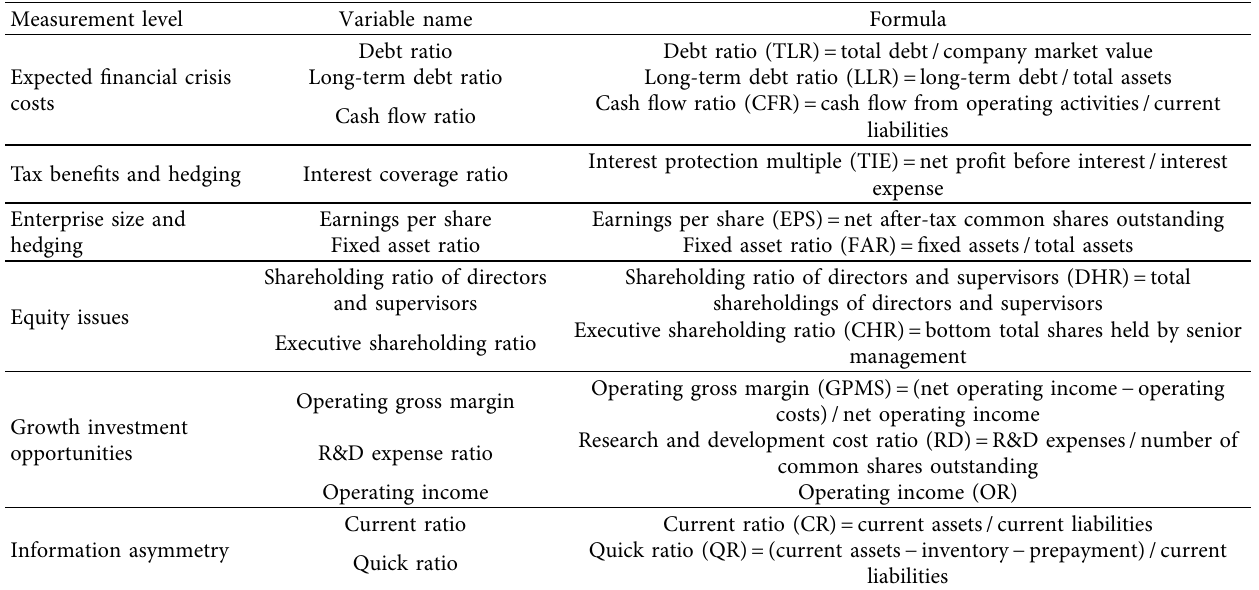
Table 1: Research